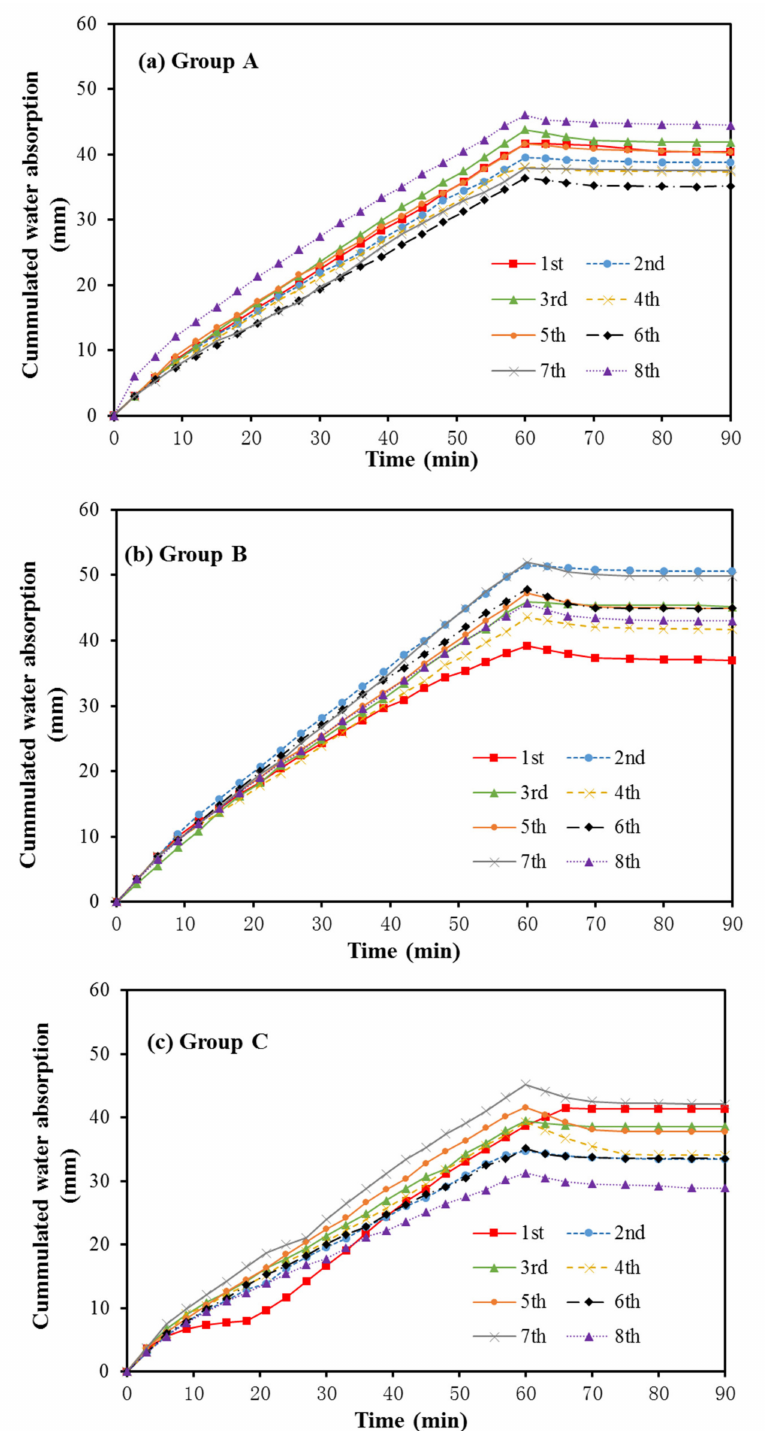
Figure 3. Repeated experiment of cumulated water absorption with ( a ) Group A with 5-year design rainfall intensity; ( b ) Group B with 10-year design rainfall intensity; ( c ) Group C with mixed of 15-year and 5-year design rainfall